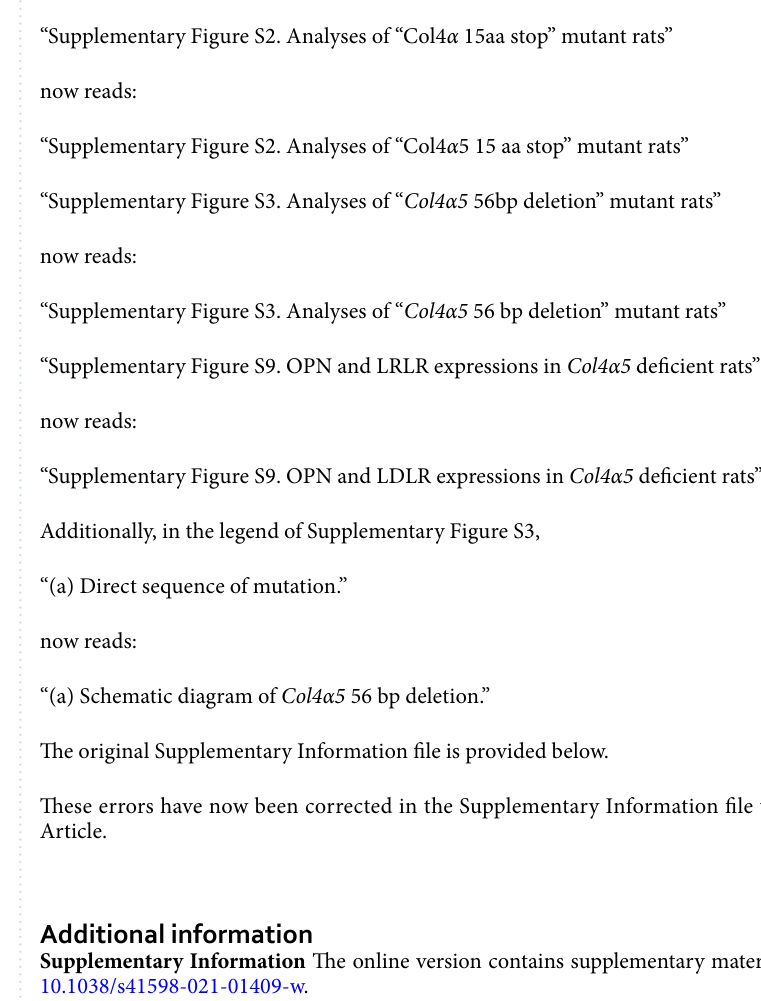
“Supplementary Figure S2. Analyses of “Col4 α 5 15 aa stop” mutant rats” “Supplementary Figure S3. Analyses of “ Col4α5 56bp deletion” mutant rats”